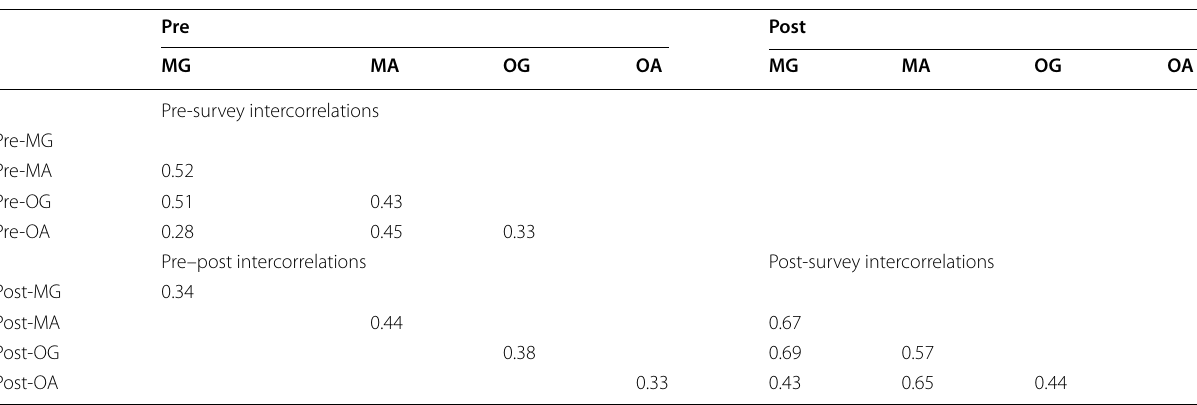
Table 2 Pearson correlations among attitudinal measures Pre